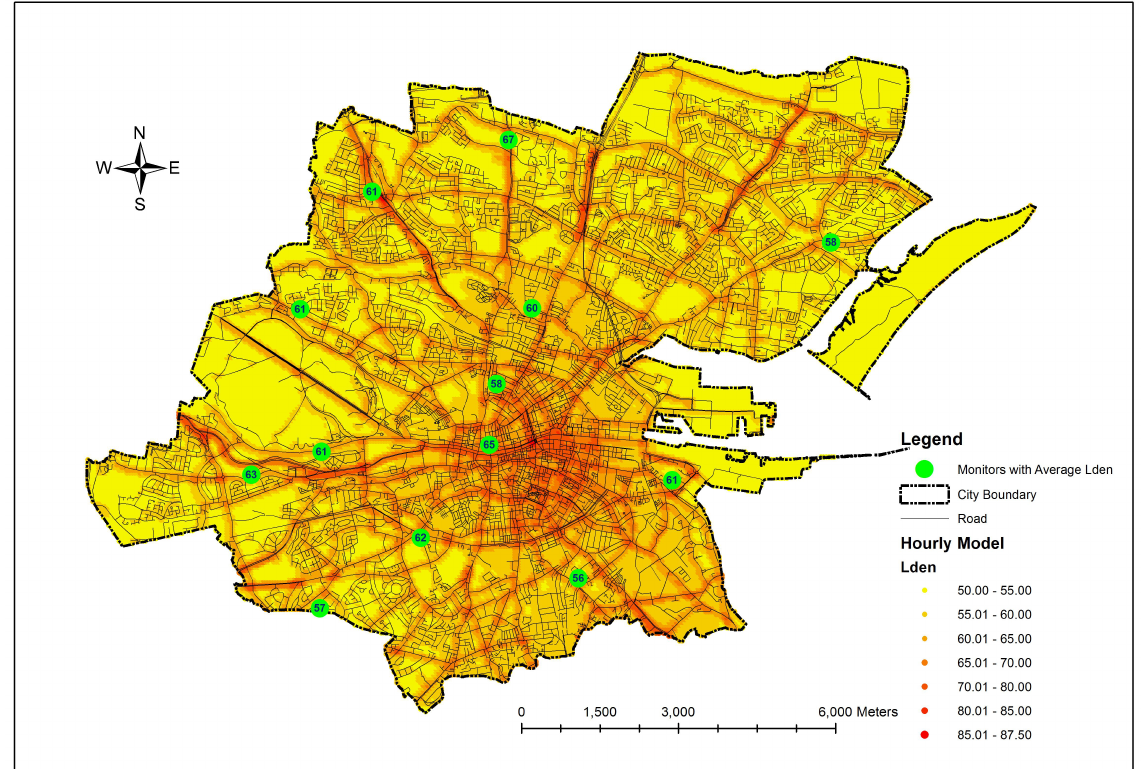
Figure 4: Map showing the spatial variation of L den , derived from Hourly H model